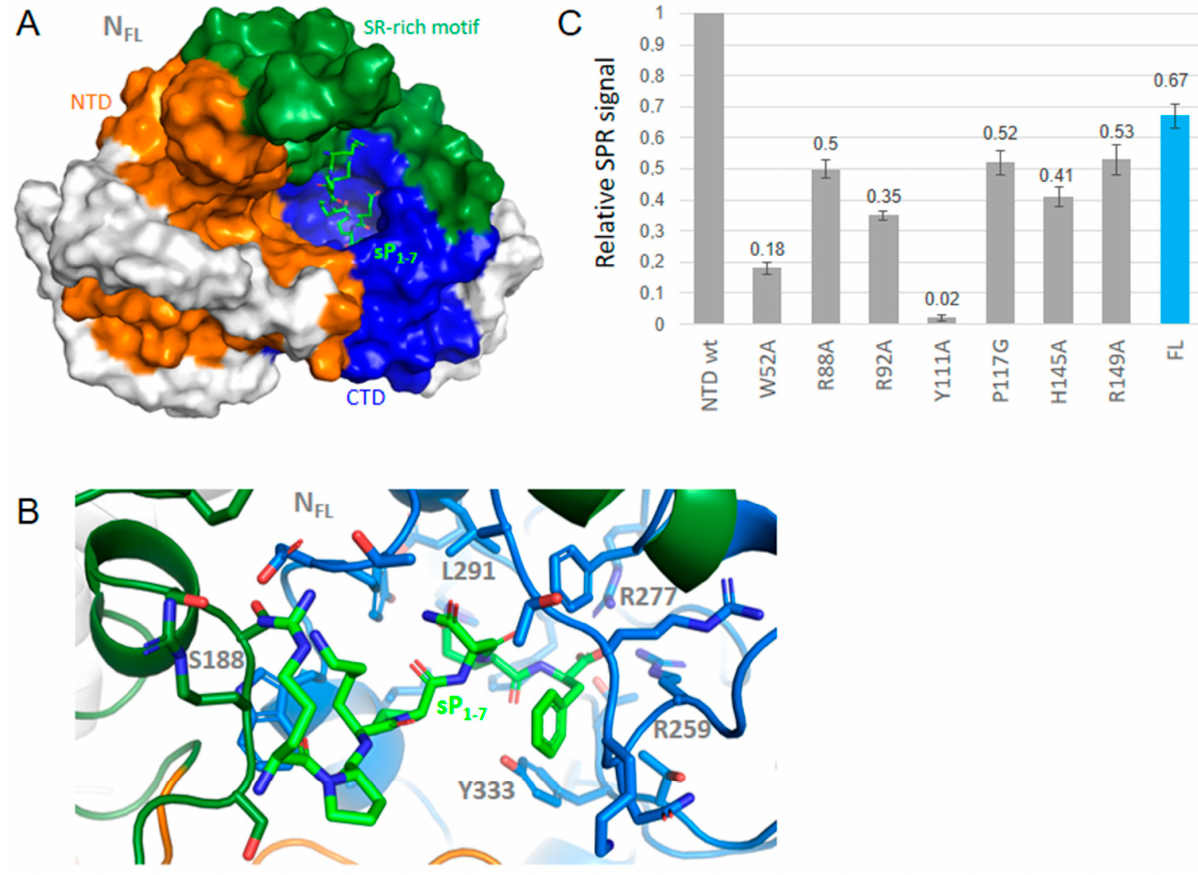
Figure 4. Interactions of wt N with substance P (1-7). ( A ) shows that the binding site of substance P (1-7) in a large binding site at FL C-terminal; ( B ) zoom on the complex of N with substance P (1-7) shown in green that formed multiple stacking and hydrophobic interactions, further stabilized by electrostatic and polar interactions; ( C ) consequently, the effect of the NTD mutations on the SPR signal was mainly observed with Y111A and W52A, with little effect seen on the other mutations. Substance P (1-7) also bound the N FL protein as measured by